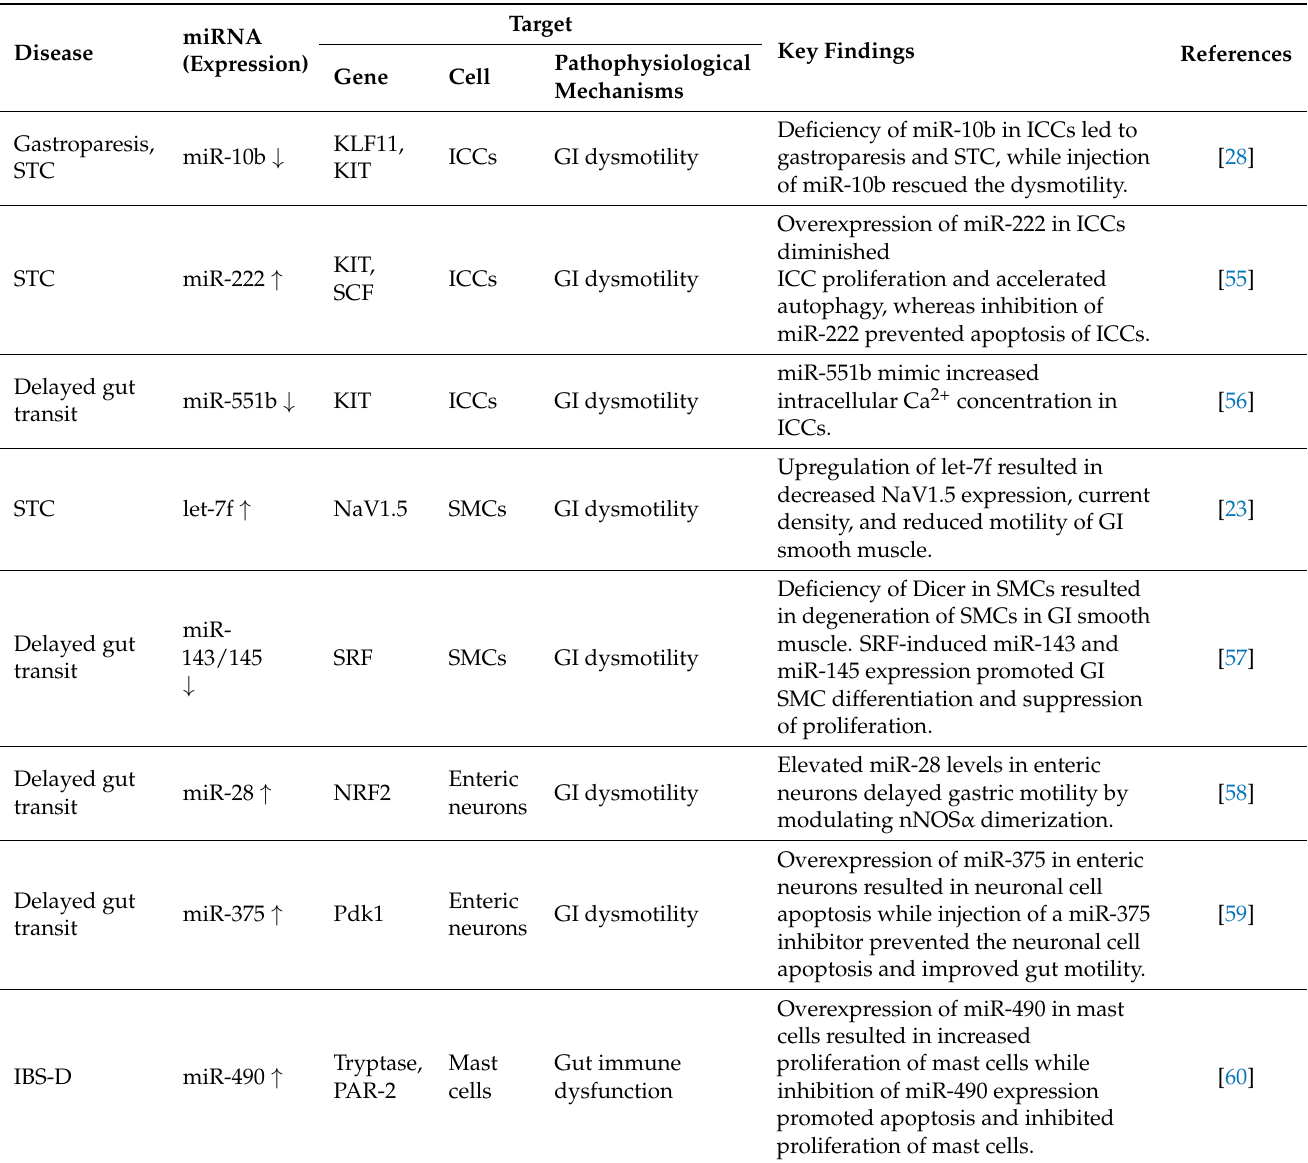
Table 1. Dysregulated miRNAs in